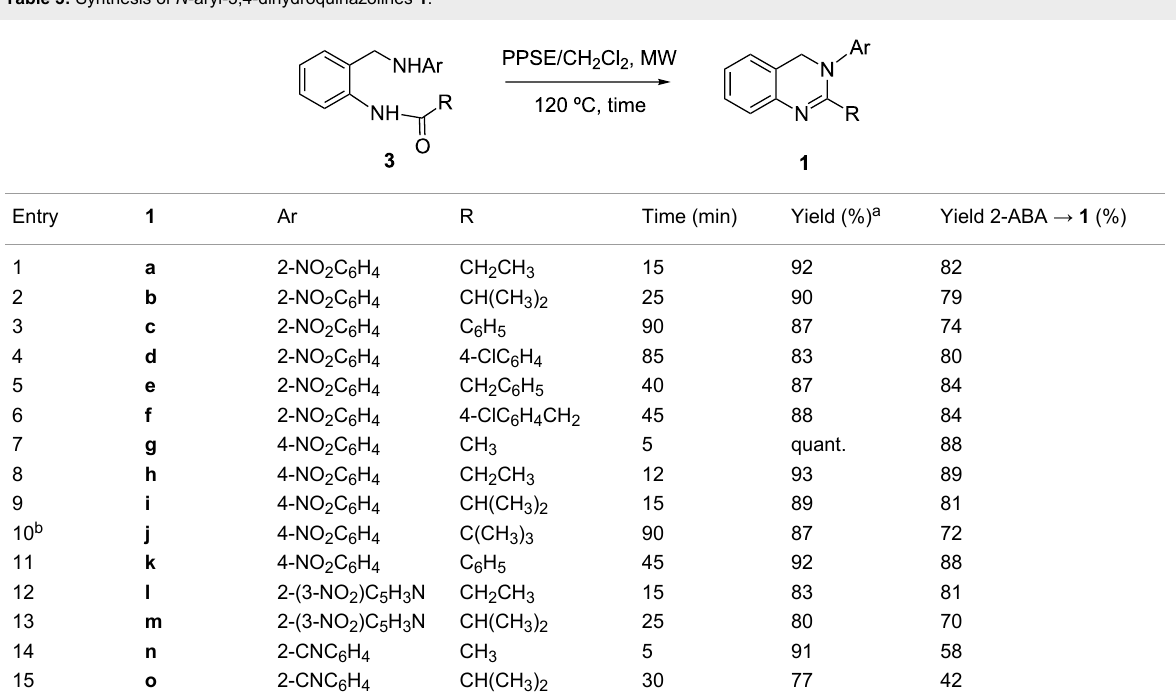
Table 3: Synthesis of N -aryl-3,4-dihydroquinazolines 1